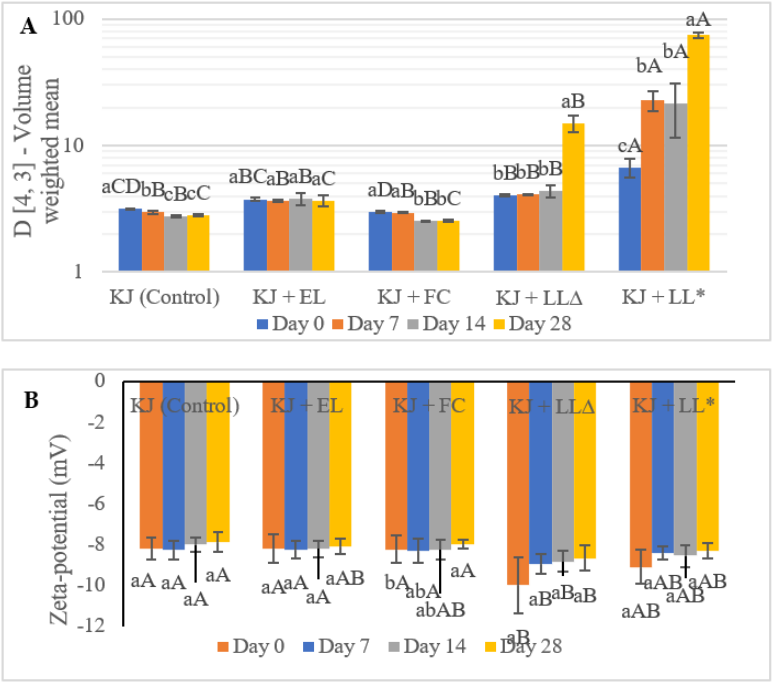
Figure 1. The particle size (D [4, 3] - Volume weighted mean (µm)) ( A ) and the zeta potential ( B ) of kiwifruit juice containing empty and green tea waste extract (GTWE)-loaded single layer liposomes (SLLs) during storage (4 °C). KJ: control kiwifruit juice; KJ + FC: kiwifruit juice containing free GTW catechins; KJ + LL ∆ : unpasteurised kiwifruit juice enriched with GTWE-loaded SLLs; KJ + LL*: pasteurised kiwifruit juice containing GTWE-loaded SLLs. Different lowercase letters indicate significant ( p < 0.05) differences among the same kiwifruit juice samples for different storage times; Different capital letters stand for statistically significant ( p < 0.05) differences among different kiwifruit juice samples on the same storage